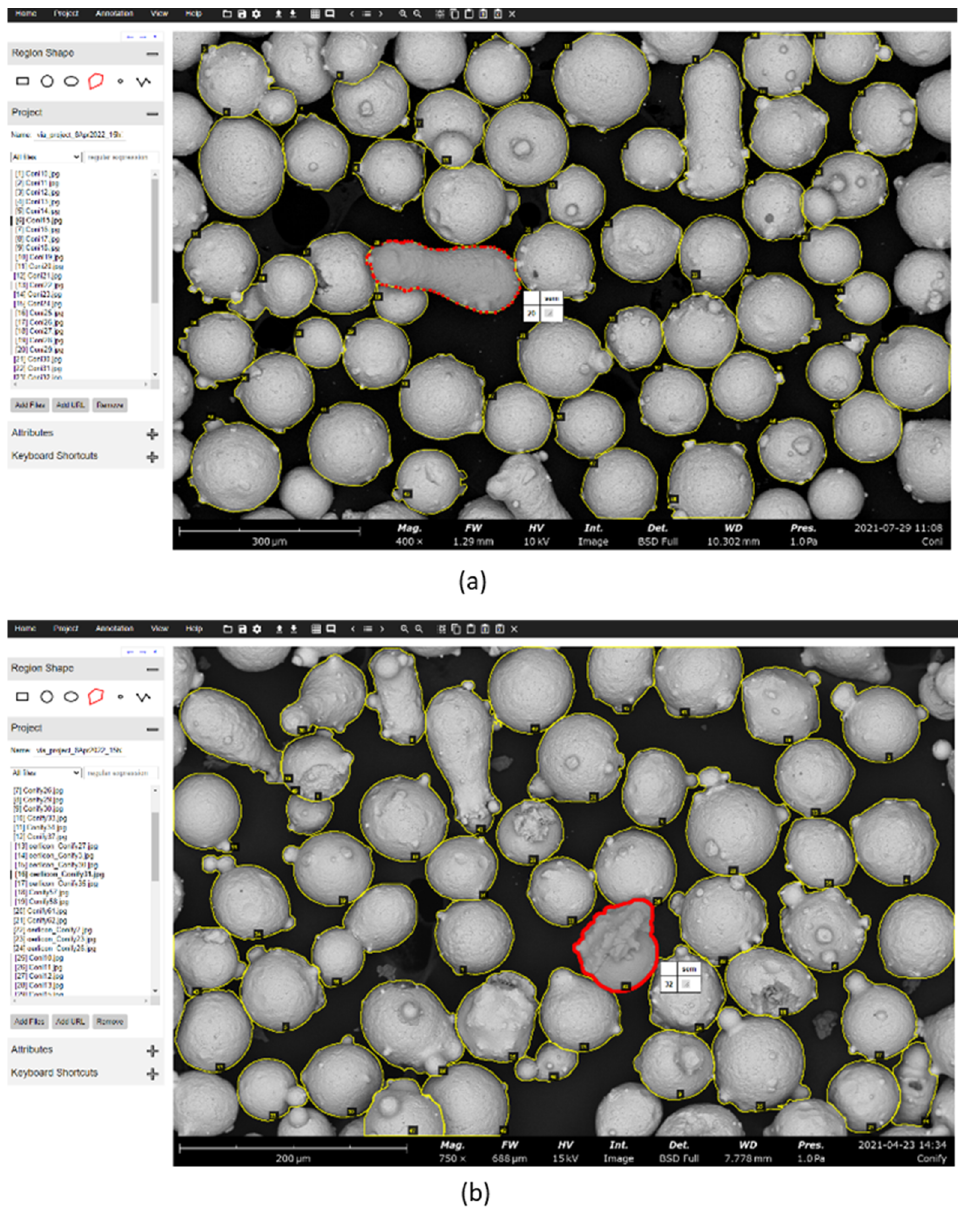
Figure 4. Manual segmented particles’ (a) and PointRend result particles’ segmentation (b).